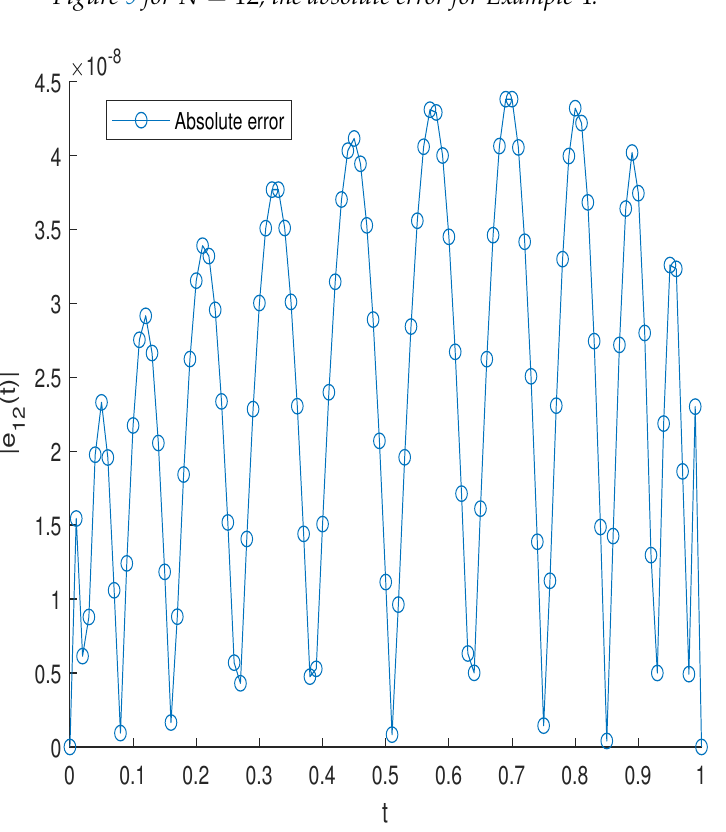
Figure 9 for N = 12 , the absolute error for Example 4 .